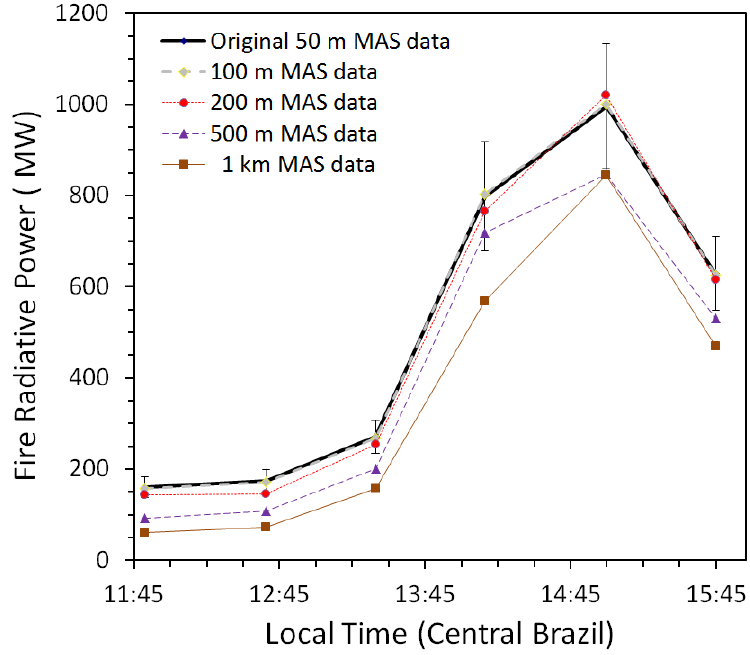
Figure 5. Total FRP measured in the northernmost MAS flight leg highlighted in Figure 1a, calculated at the six different MAS overflight times (11:50, 12:40, 13:25, 14:10, 15:00, 15:45 local time) and using both the original 50 m spatial resolution data and the four spatially degraded versions (100 m, 200 m, 500 m, 1 km; see examples in Figure 3). Uncertainty estimates in FRP (vertical error bars) are shown only for the original 50 m MAS data for clarity.